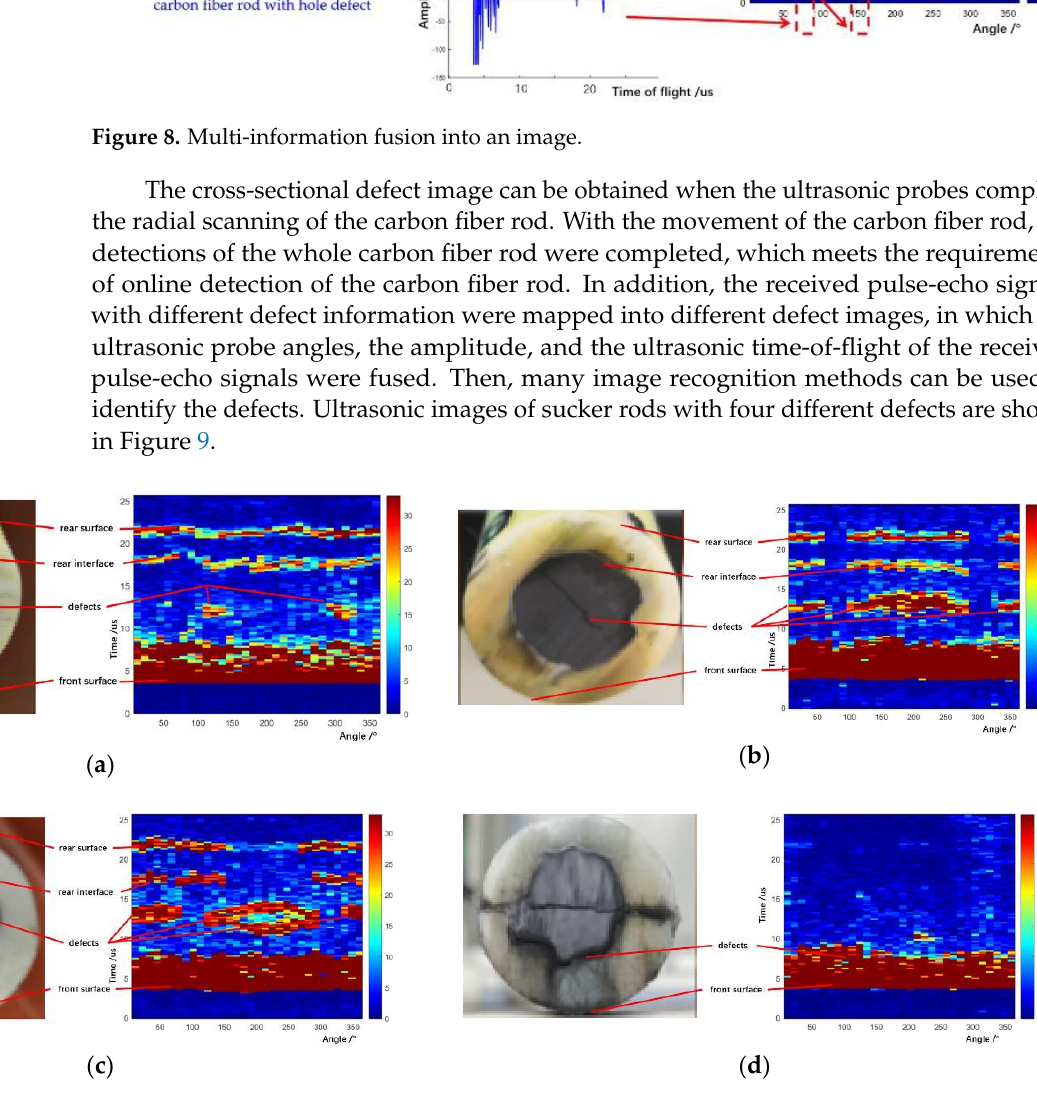
Figure 9. Ultrasonic images of sucker rods with different defects: ( a ) small crack defect, ( b ) transverse crack defect, ( c ) hole defect, and ( d ) chapped defect.